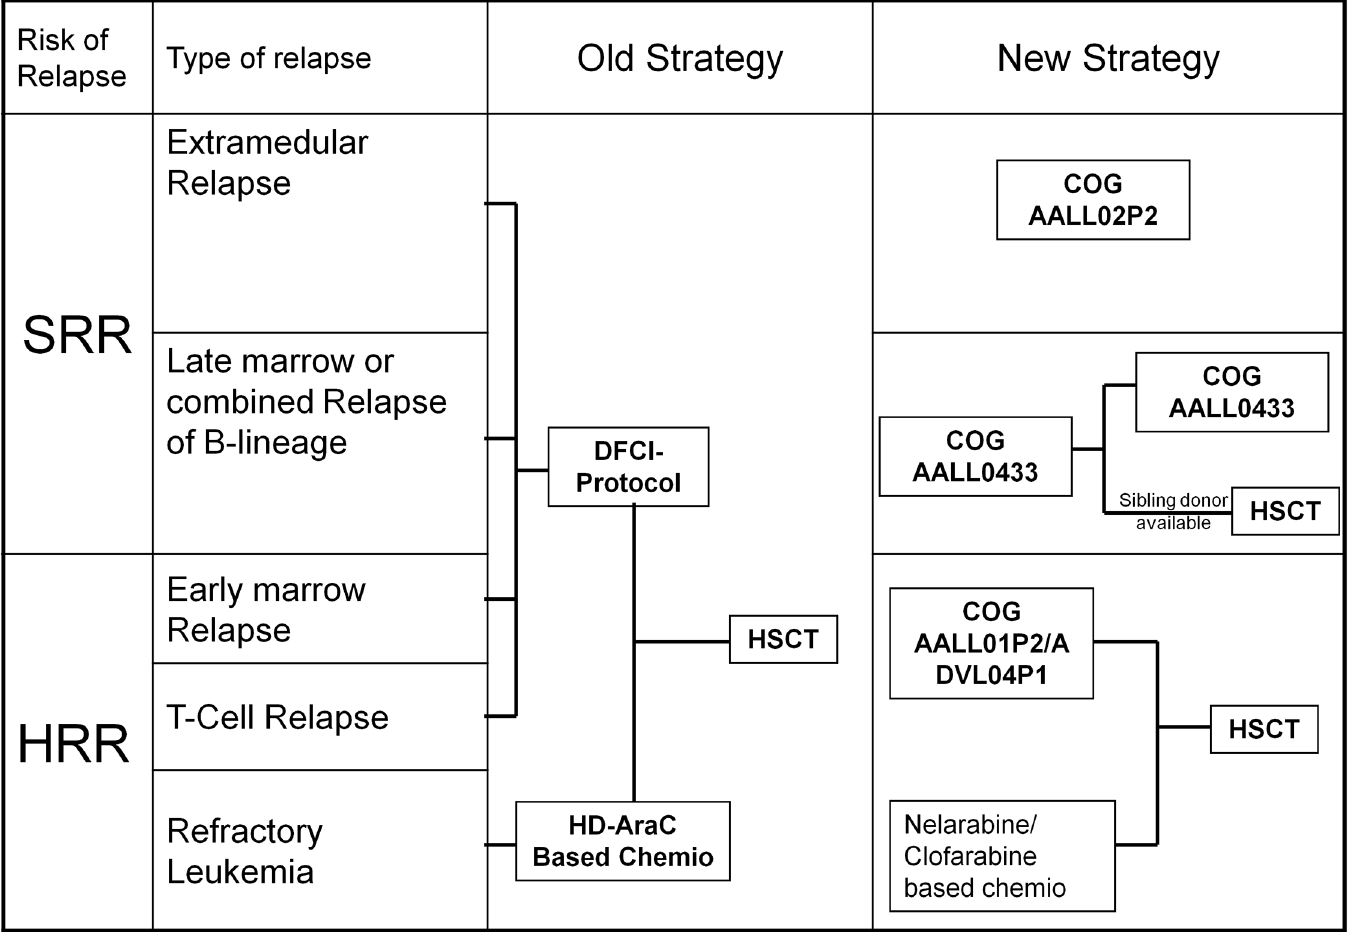
Fig 1. Previous and new treatment strategies for standard risk relapse (SRR) and High risk relapse or refractoriness (HRRR), before and after 2007. HSCT, haematopoietic stem cell transplantation; AraC, Cytarabine; COG, Children Oncology Group; DFCI, Dana-Farber Cancer